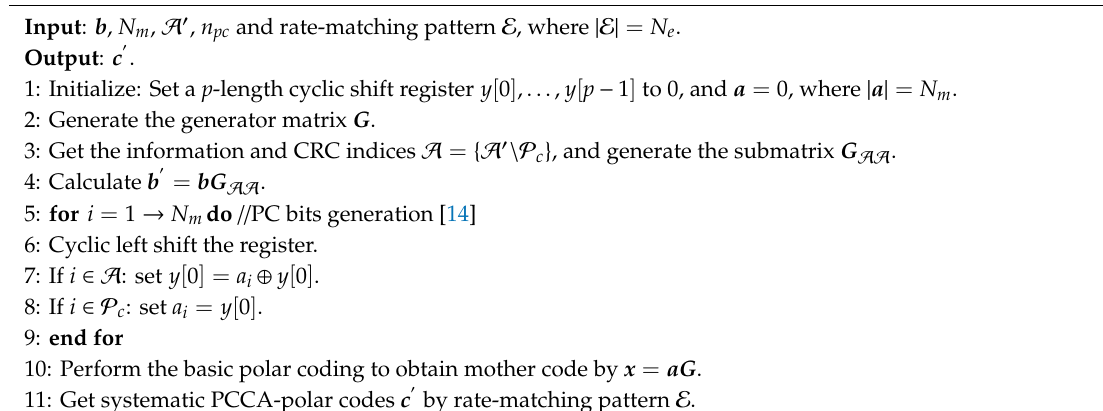
Algorithm 2 Systematic PCCA-polar encoding